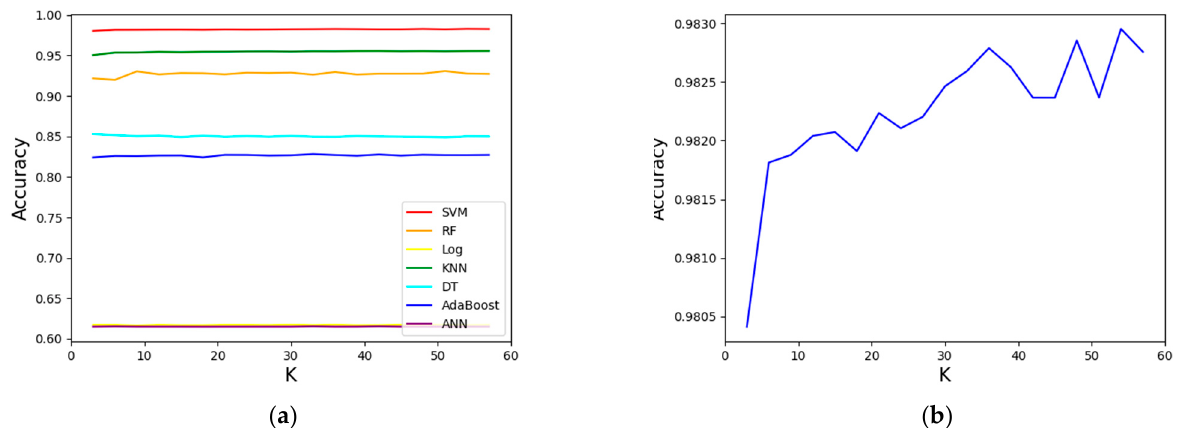
Figure 7. The effects of K-fold method. ( a ) Comparation between SVM with other methods. ( b ) K-fold of SVM.